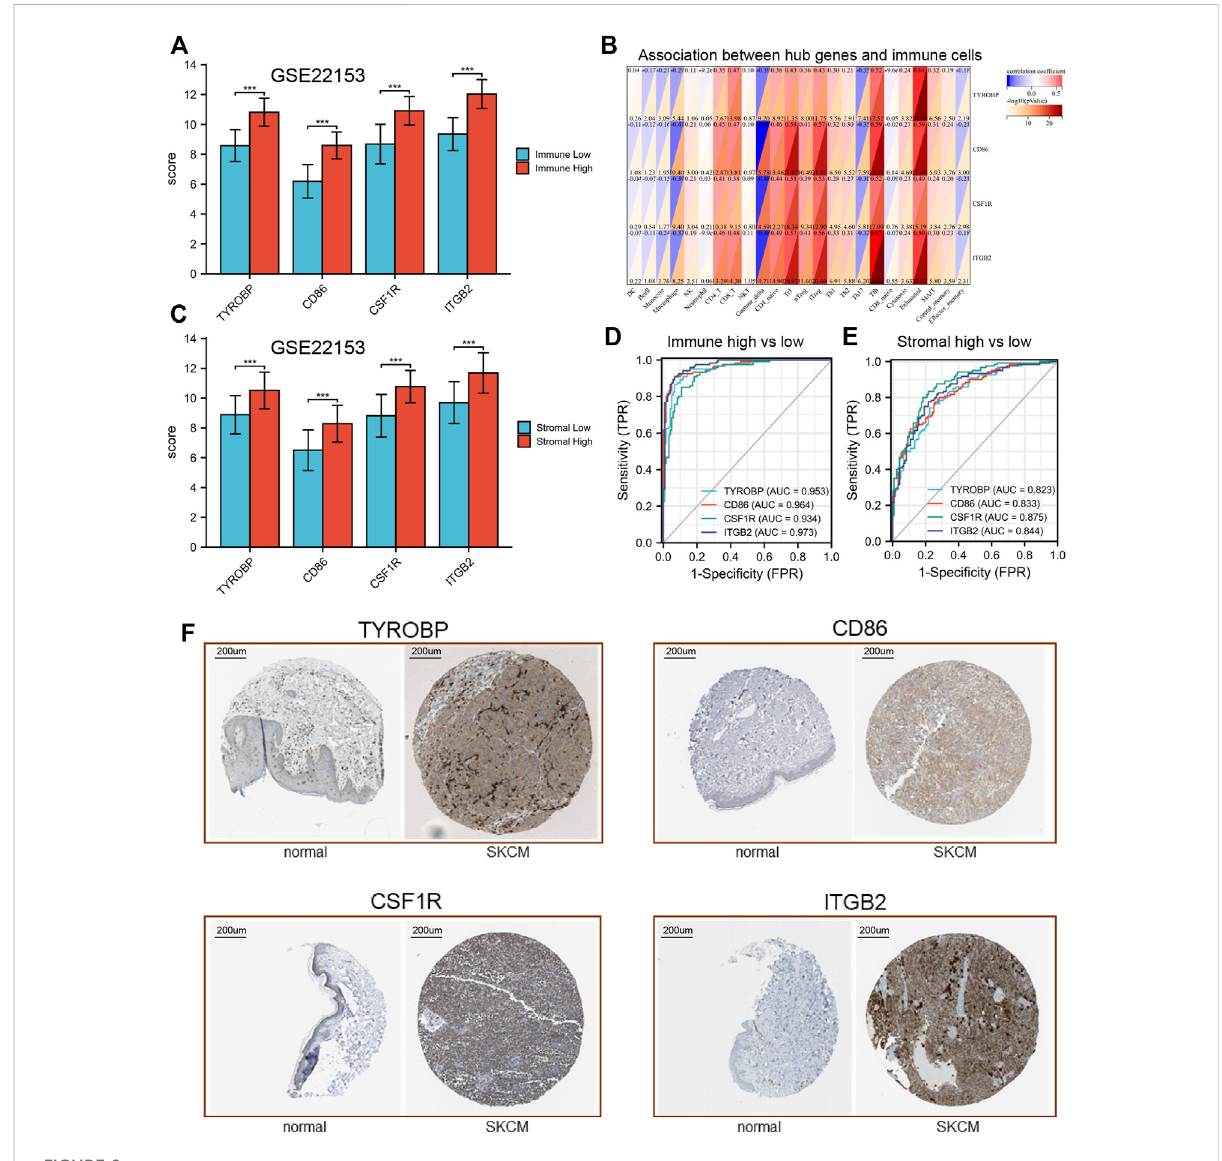
FIGURE 9 Validation of hub genes expression. (A) expression levels of hub genes in GSE22153. (B) association between hub genes and immune cells. (C) expression levels of hub genes in GSE22153. (D , E) , ROC curves of hub genes. (F) IHC results of hub